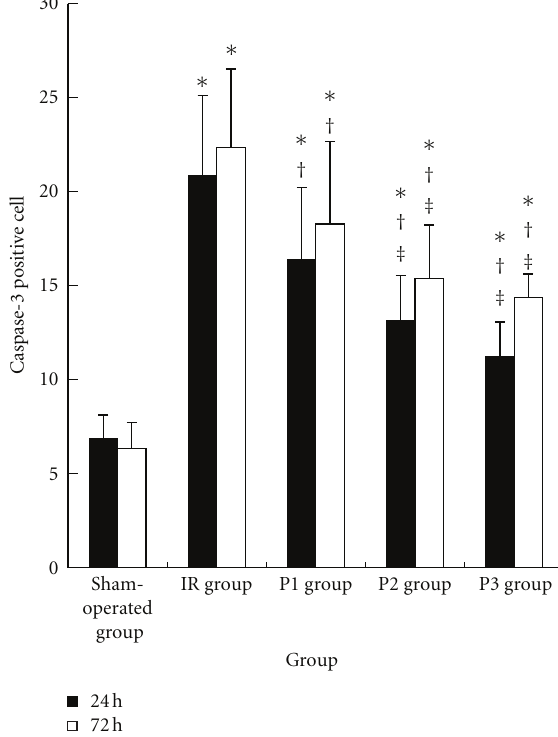
Figure 3: Caspase-3 positive cells in brain slices of five groups at 24h and 72 h. Data are presented as means ± SD. ∗ P < 0 . 01, versus sham-operated group. There were significant di ff erences in IR, P1, P2, P3 groups than that in sham-operated group; † P < 0 . 05, versus IR group. There were significant di ff erences in P1, P2, P3 groups than that in IR group; ‡ versus P1 group. There were significant apoptosis in P2, P3 groups. But, in 72h, there was no obvious di ff erence between P2 and P3